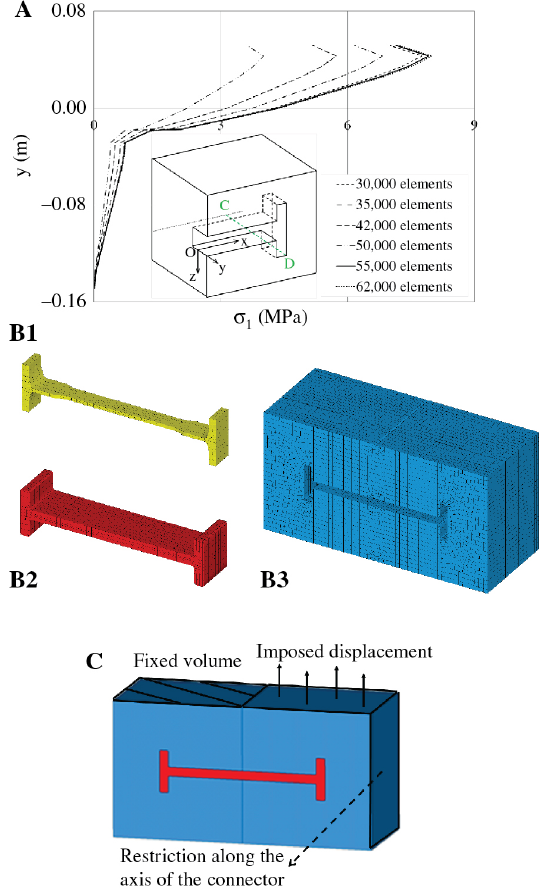
Figure 5: (A) Convergence analysis to determine the optimum size (and therefore the number) of the elements of the mesh based on the variation of the maximum principal stress along the CD line of the marble. (B) The final mesh for each one of the three materials of the model: (B1) The titanium connector, (B2) the cement-based filling material and (B3) the marble epistyles. (C) The boundary conditions and the loading scheme